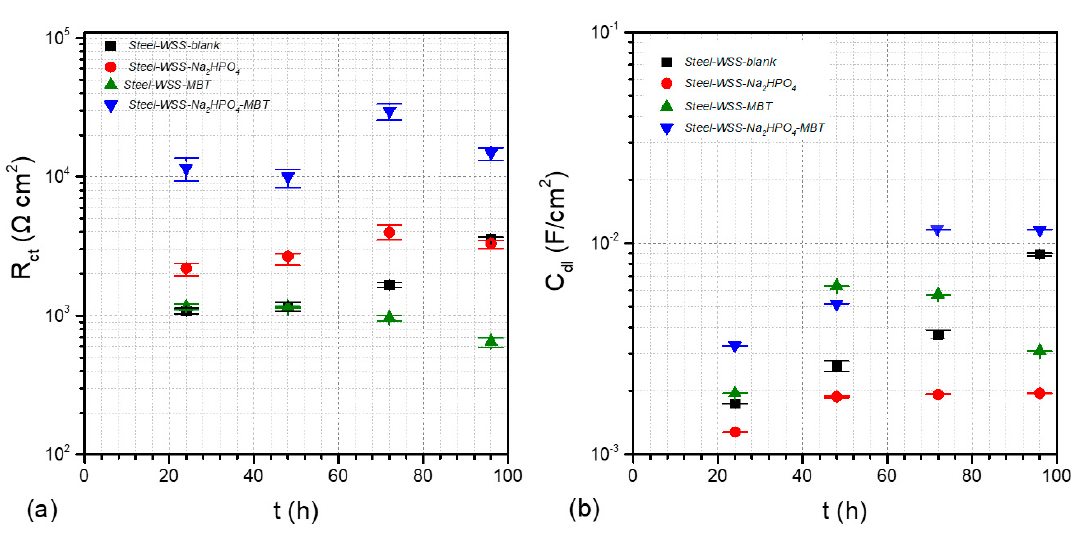
Figure 22. The evolution of the mean values of the EIS fitting parameters as a function of time for mild steel panels after submission in WSS: ( a ) R ct , ( b ) C dl .